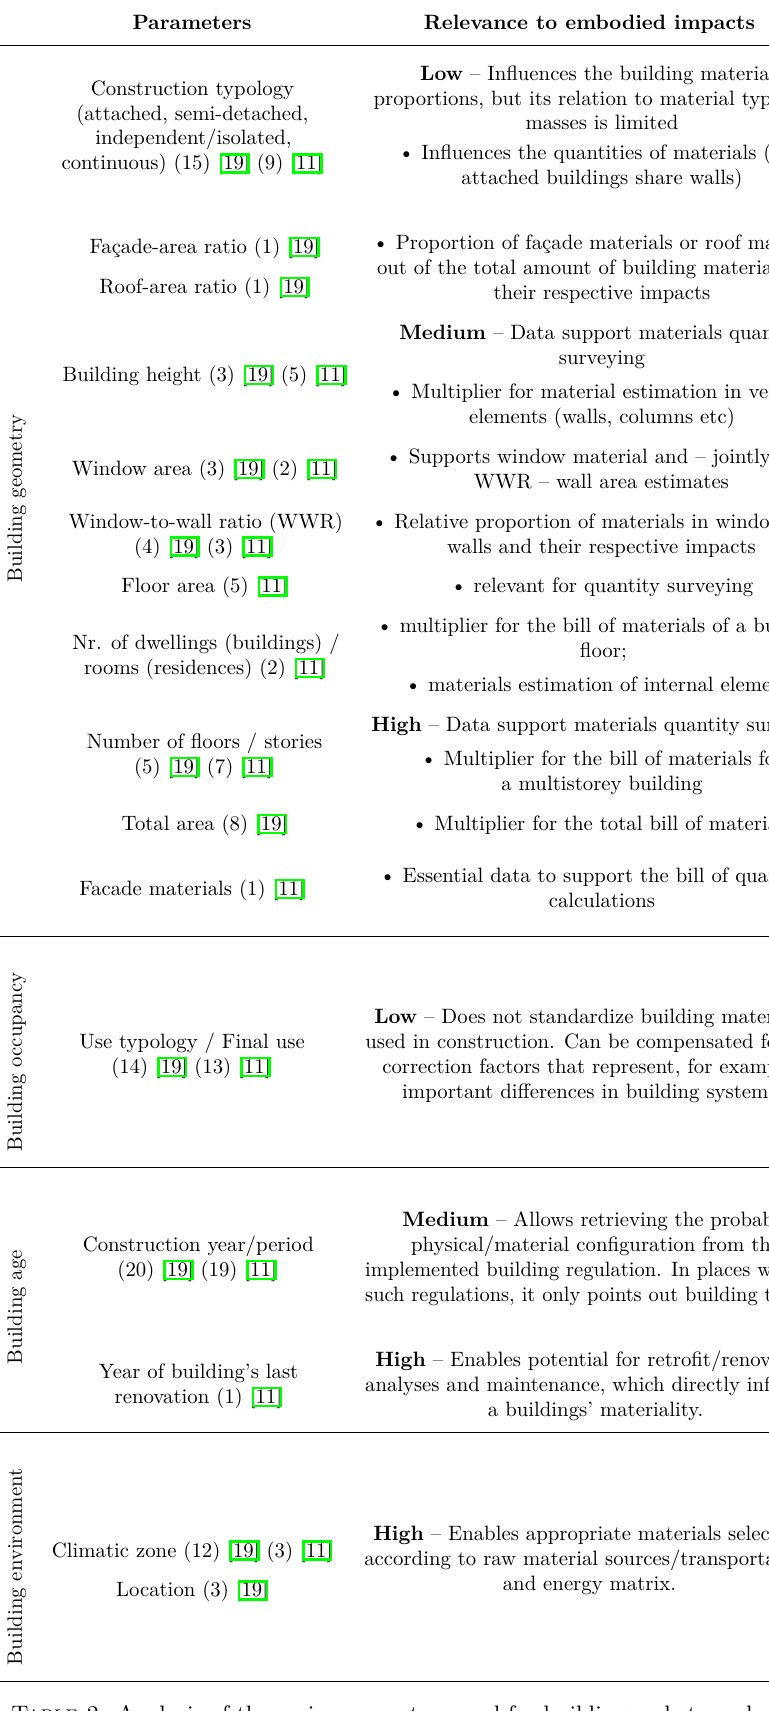
Table 2. Analysis of the main parameters used for building archetype development. Numbers within parentheses indicate the occurrences in the reviewed